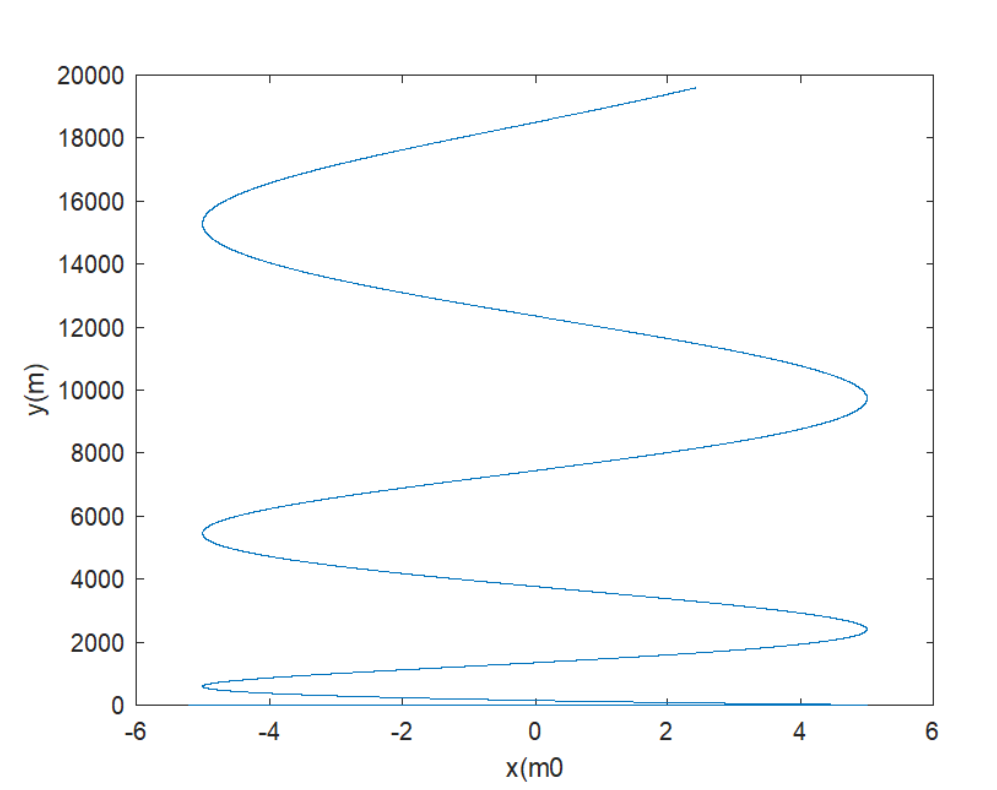
Figure 19. Bias fault: control result without sensor handling: the 2D position